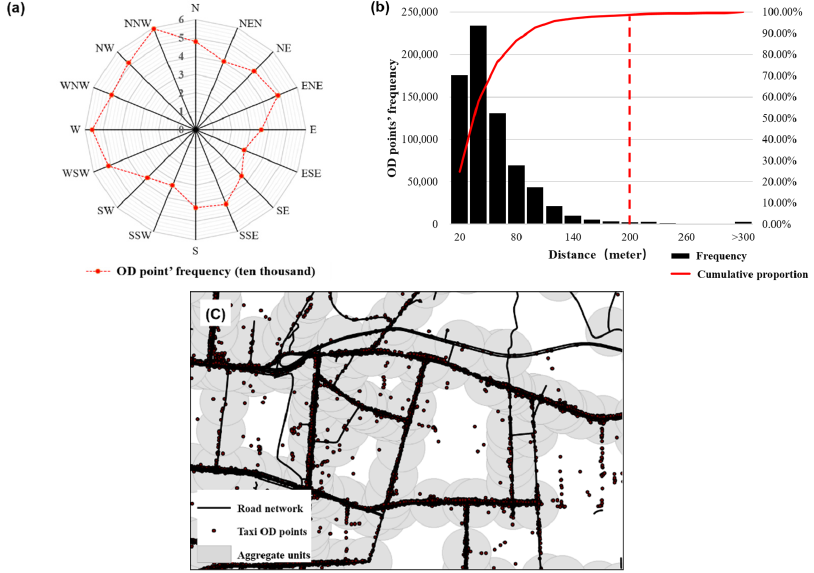
Figure 3. Illustration of the aggregate unit: ( a ) chart of the OD frequency in each direction of the road intersection, ( b ) chart of the distances from the OD points to the nearest road intersection, and ( c ) diagram of the aggregate unit.